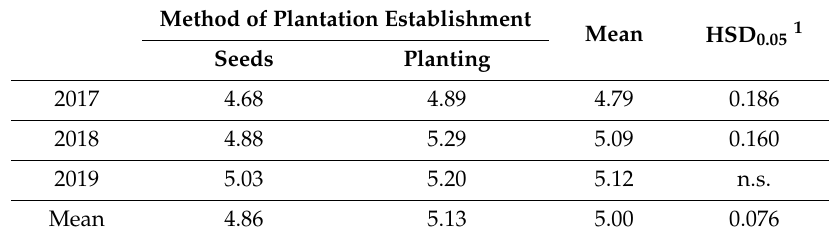
Table 8. The Leaf Area Index of Silphium (m 2 · m − 2 ), depending on methods of plantation establishment. Method of Plantation